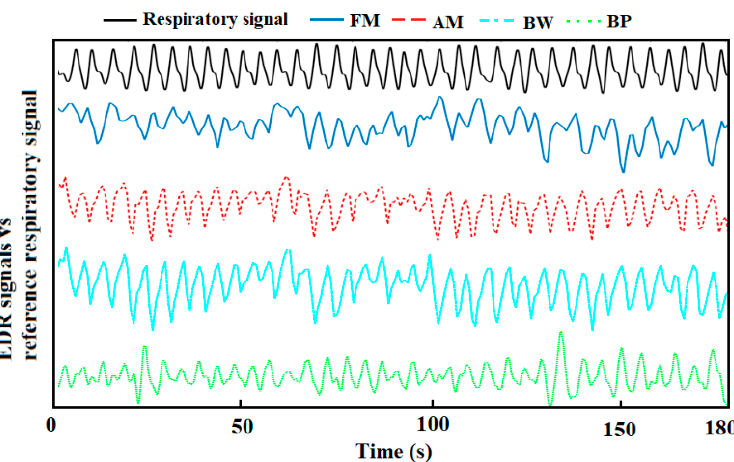
Figure 3. A representative derived respiration signals from auscultation site ECG and reference respiration signal.